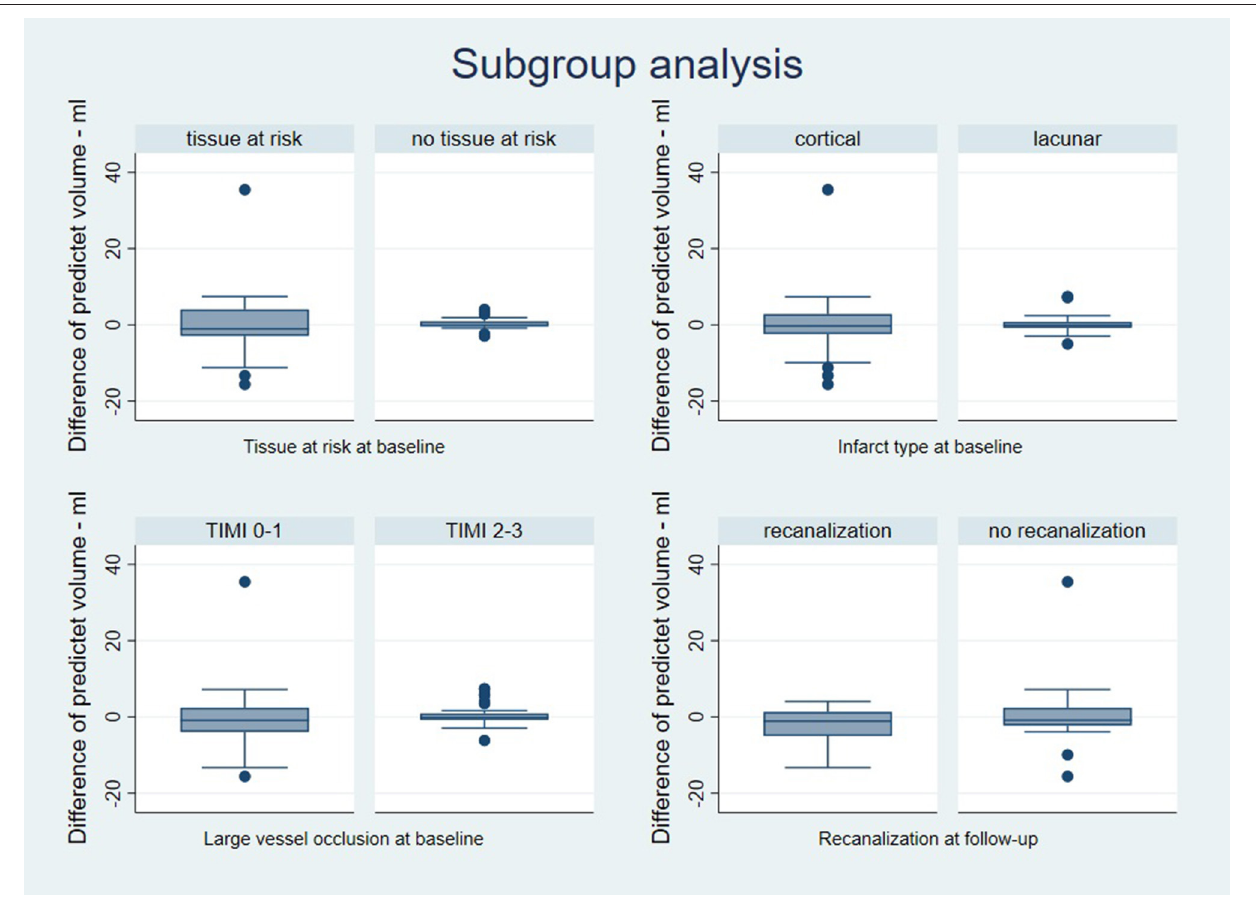
FIGURE 3 | Subgroup analysis. Box-whisker diagrams depicting the predicted volume of follow-up lesions plotted as the difference between the two predictions (theophylline and placebo) for each patient: Values < 0 indicate that theophylline is better than placebo and values > 0 indicate that placebo is better than theophylline indicating no significant difference for patients with and without tissue-at-risk at baseline, for patients with cortical vs. lacunar infarction, for patients with and without large vessel occlusion at baseline, and for patients with and without recanalization at